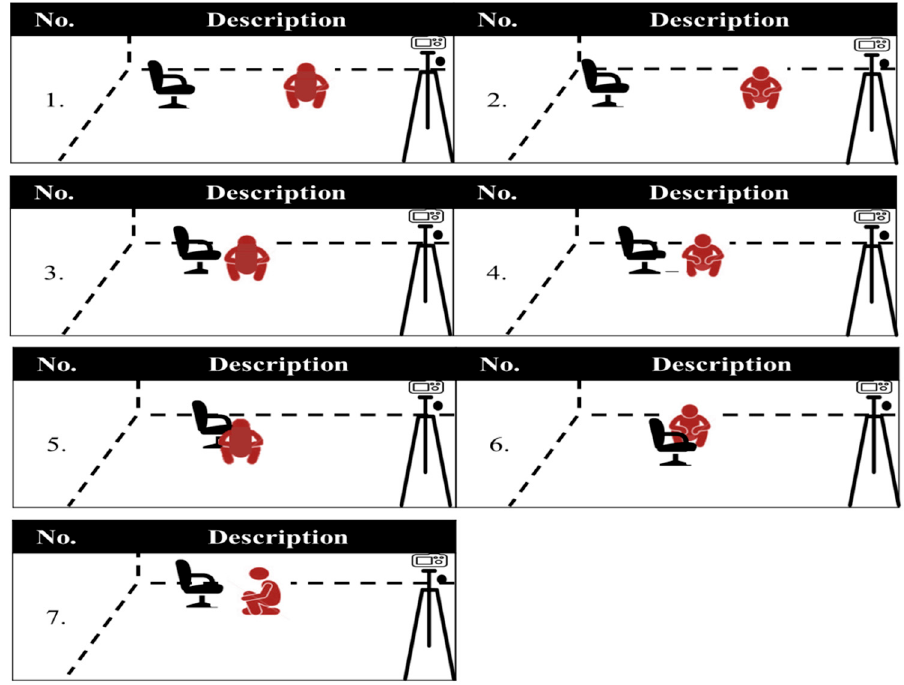
Figure 14. An illustration of the squatting cases.